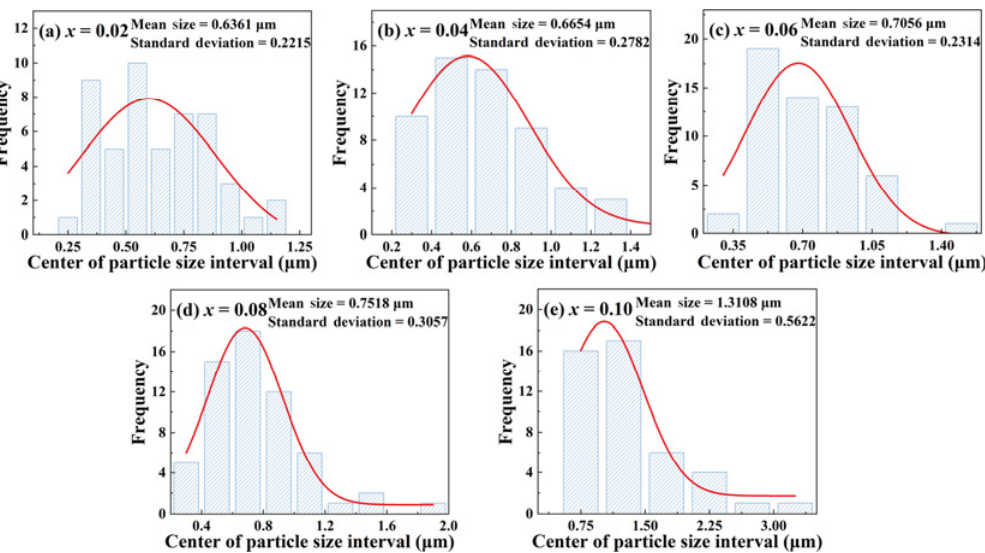
Fig. 5 Grain size distributions of NZ 1 − x T x M ( x = 0.02–0.10) ceramics sintered at optimal temperatures.